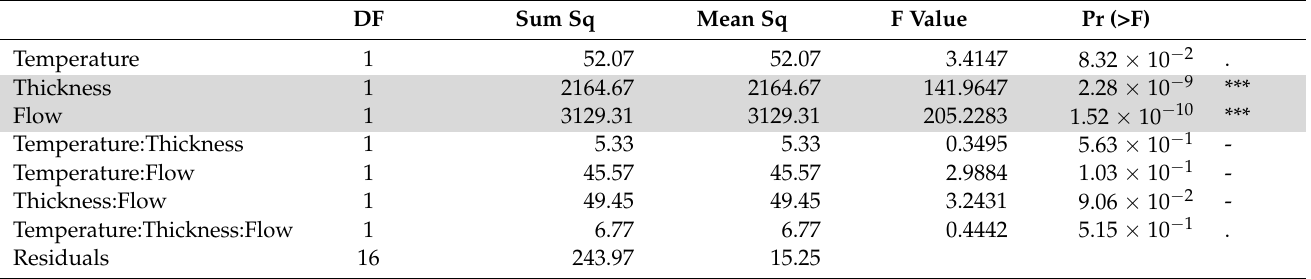
Table 11. Statistical significance of the effects of the printing parameters and their interactions on samples tensile strain at maximum